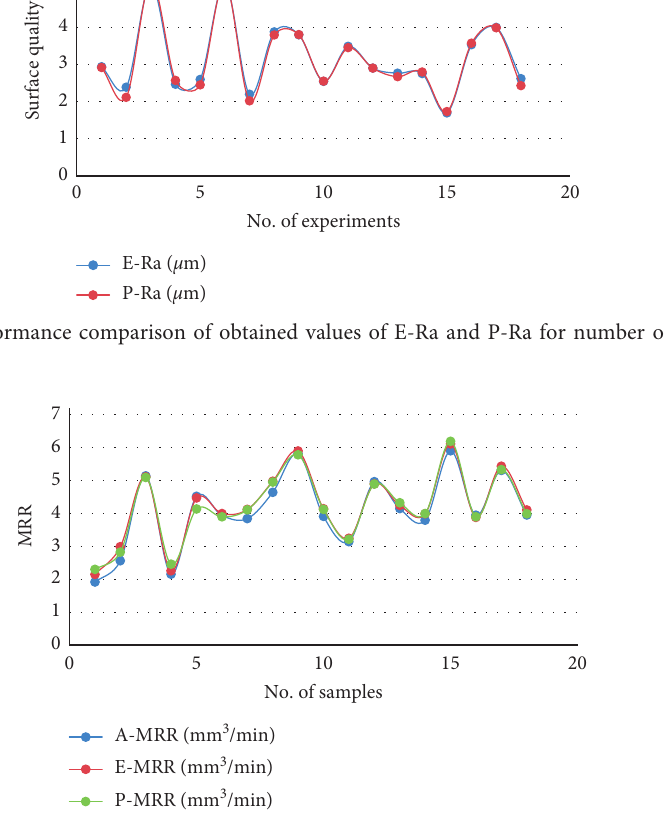
Figure 11: Performance comparison graph of MRR using FEM and experimental and feed forward BPNN